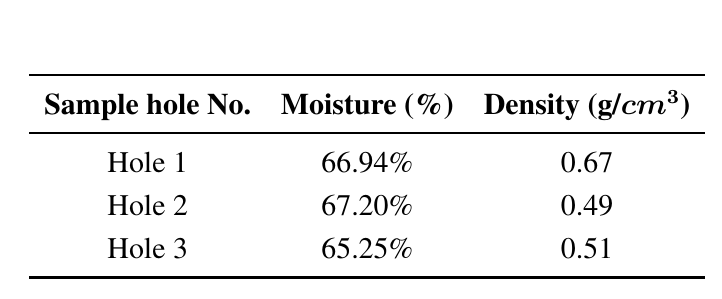
Table 3. Moisture content and density of the samples made up from the material drilled out of the holes.